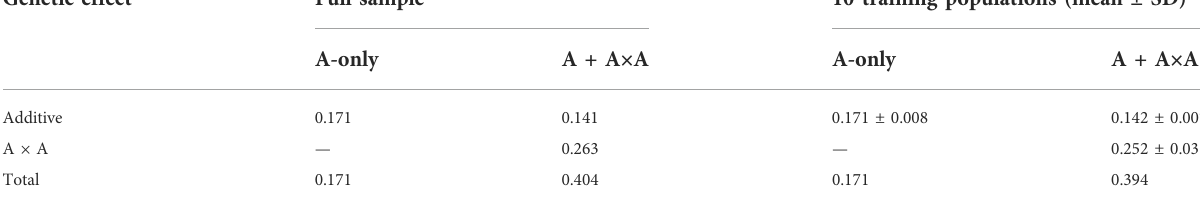
TABLE 1 Genomic heritability estimates for the A-only and A + A×A prediction models. Genetic